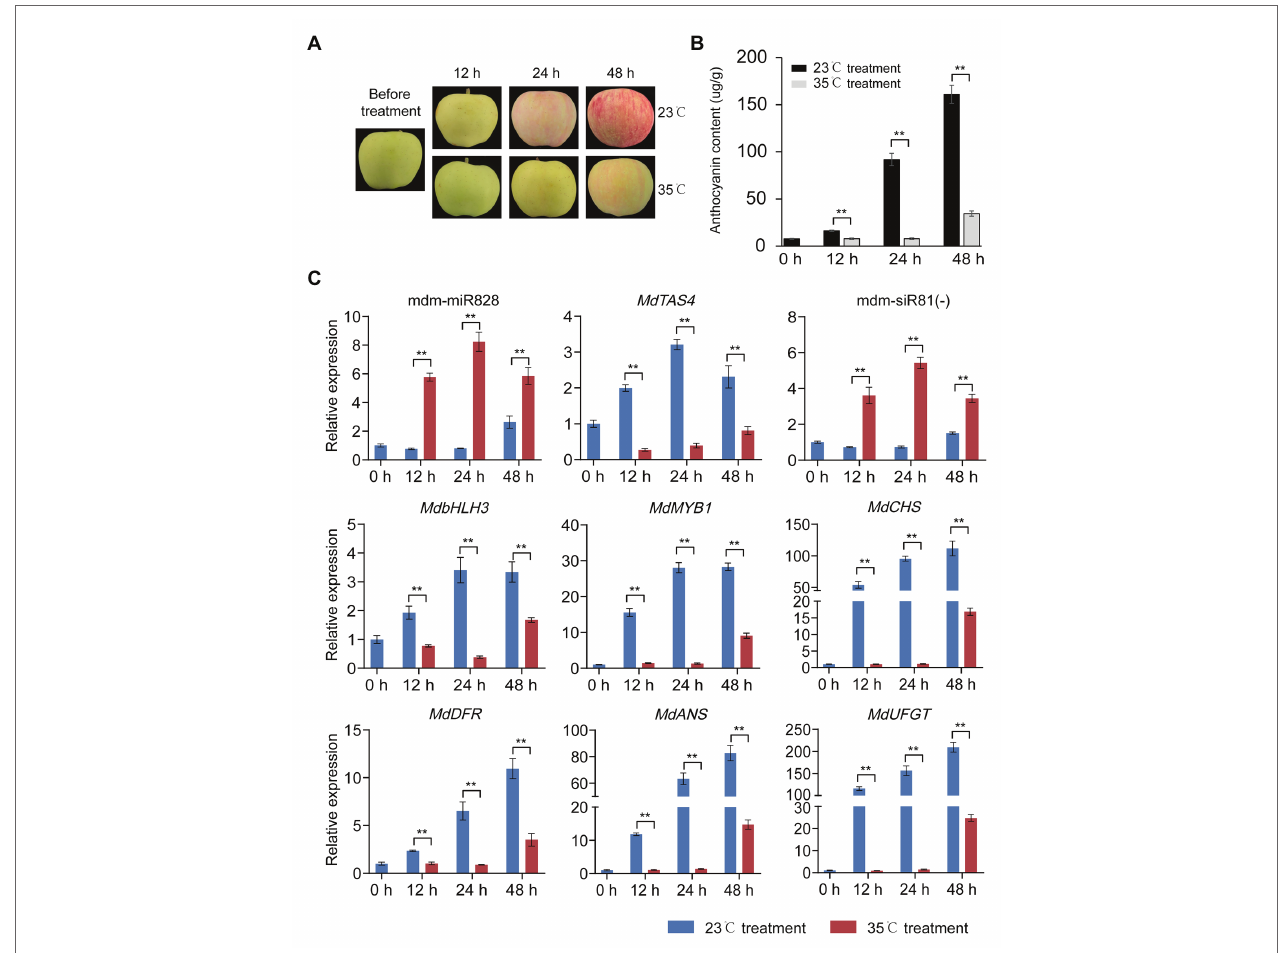
FIGURE 5 | High temperature inhibits anthocyanin accumulation in apple peel. (A) Change in color of “Starkrimson Delicious” peel under high temperature. (B) Anthocyanin content in the peel under high temperature. (C) Relative expression level of mdm-miR828, mdm-siR81( − ), and anthocyanin-related genes ( MdTAS4 , MdbHLH3 , MdbMYB1 , MdCHS , MdDFR , MdANS , and MdUFGT ) under high temperature. Error bars represent the standard deviation of three biological replicates. ** p < 0.01 (Student t